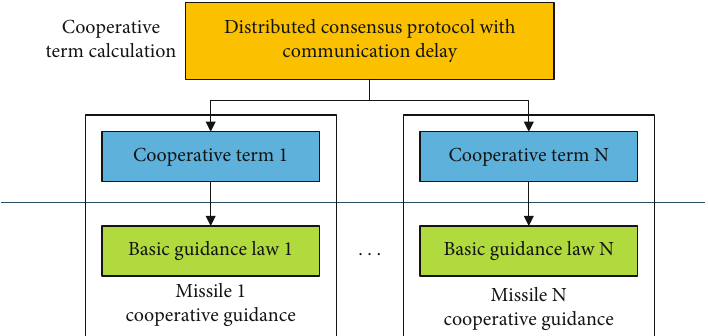
Figure 2: The scheme of the DCMG law with communication